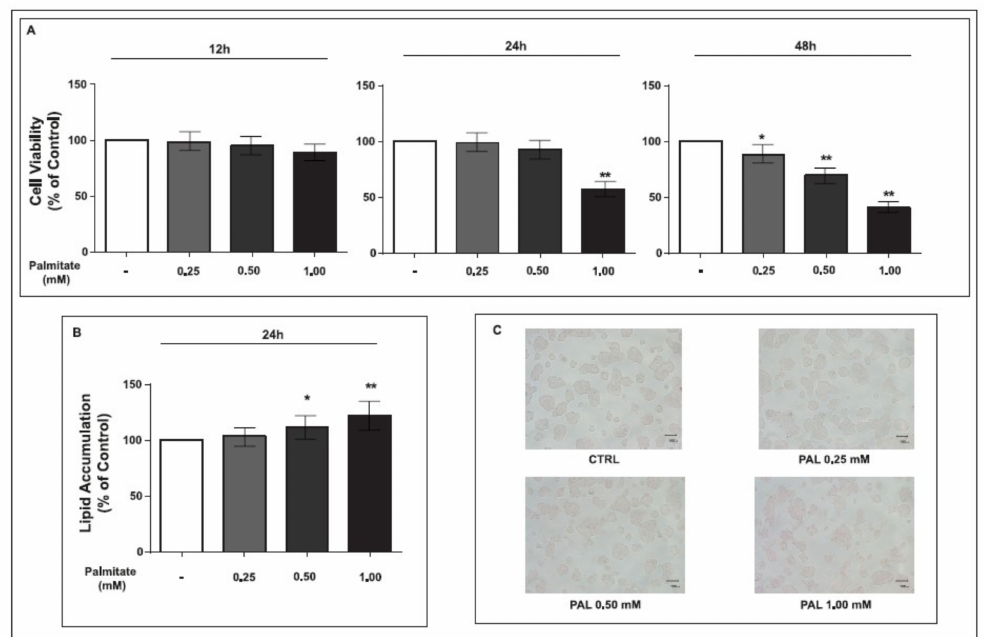
Figure 1. Effect of pre-exposure to palmitate on cell viability and lipid accumulation in GLUTag cells. A : MTT assay in GLUTag cells pre-exposed to palmitate (0.25, 0.50 and 1.00) after 12 h, 24 h and 48 h. Data are expressed as means ± standard error of 570 nM absorbance to % of control. * p < 0.05, ** p < 0.01, vs. control ( t -test, n = 6). B : Nile Red staining in GLUTag cells pre-exposed to palmitate (0.25, 0.50 and 1.00 for 24 h). Data are expressed as means ± standard error of fluorescence to % of control. * p < 0.05, ** p < 0.01, vs. control ( t -test, n = 6). C : Oil red O staining in GLUTag cells treated with palmitate (0.25, 0.50 and 1.00 for 24 h). A slight increase in Oil red O stained droplets (red) is visible in the cells treated with palmitate (0.50 and 1.00 mM) as compared with non-treated cells (40 ×